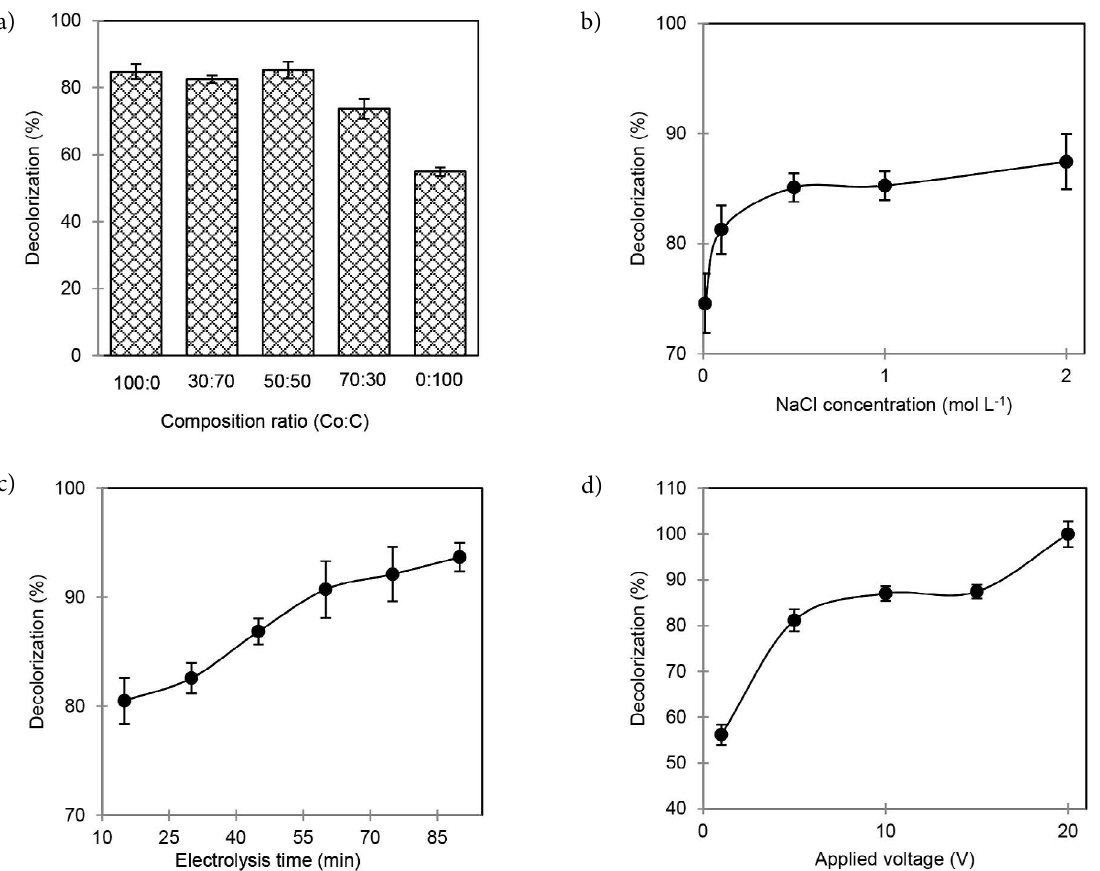
Figure 3. Decolourisation percentage of aqueous RB21 by using different (a) Co:C ratio in the prepared electrode ([RB21] o = 50 mg L –1 ; [NaCl] = 1.0 mol L –1 ; E = 5 V; I = 0.62 A; t = 15 min); (b) NaCl concentration ([RB21] o = 50 mg L –1 ; I = 0.02–1.12 A (for 0.01 – 2.0 mol L –1 NaCl); E = 5 V; t = 15 min; anode = Co 47.5 /C 47.5 -PVC 5 ); (c) electrolysis time ([RB21] o = 50 mg L –1 ; [NaCl] = 0.5 mol L –1 ; E = 5 V; I = 0.36 A; anode = Co 47.5 /C 47.5 - PVC 5 ); (d) applied voltage ([RB21] o = 50 mg L –1 ; [NaCl] = 0.5 mol L –1 ; t = 45 min; I = 0.06–0.93 A (for 1–20 V); anode = Co 47.5 /C 47.5 –PVC 5